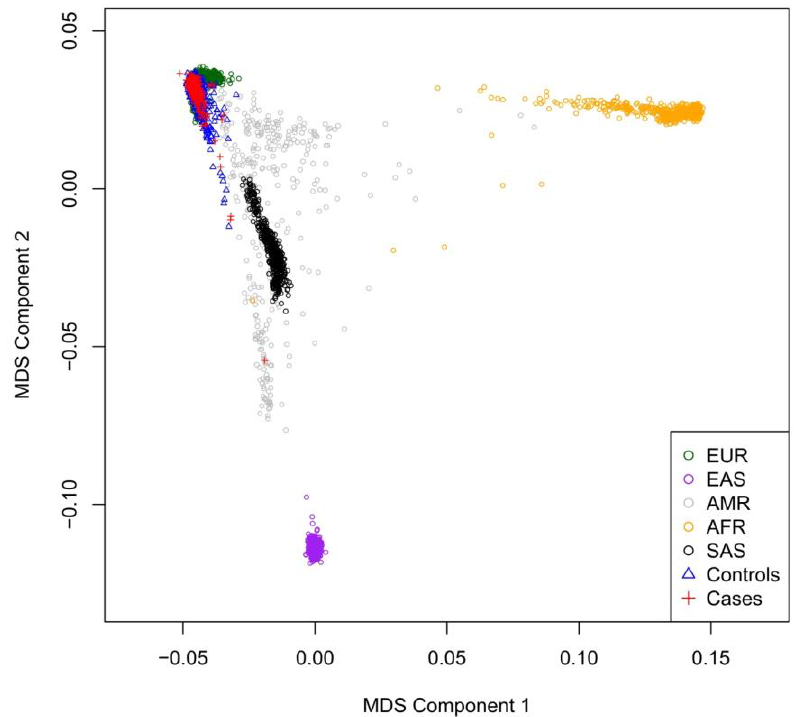
Figure 2. Results of multidimensional scaling of this cohort and several large human populations. Indicated ancestries are: EUR—European, EAS—East Asian, AMR—American, AFR—African, SAS—South Asian. One outlier among cases (red cross) was excluded from the downstream analysis.